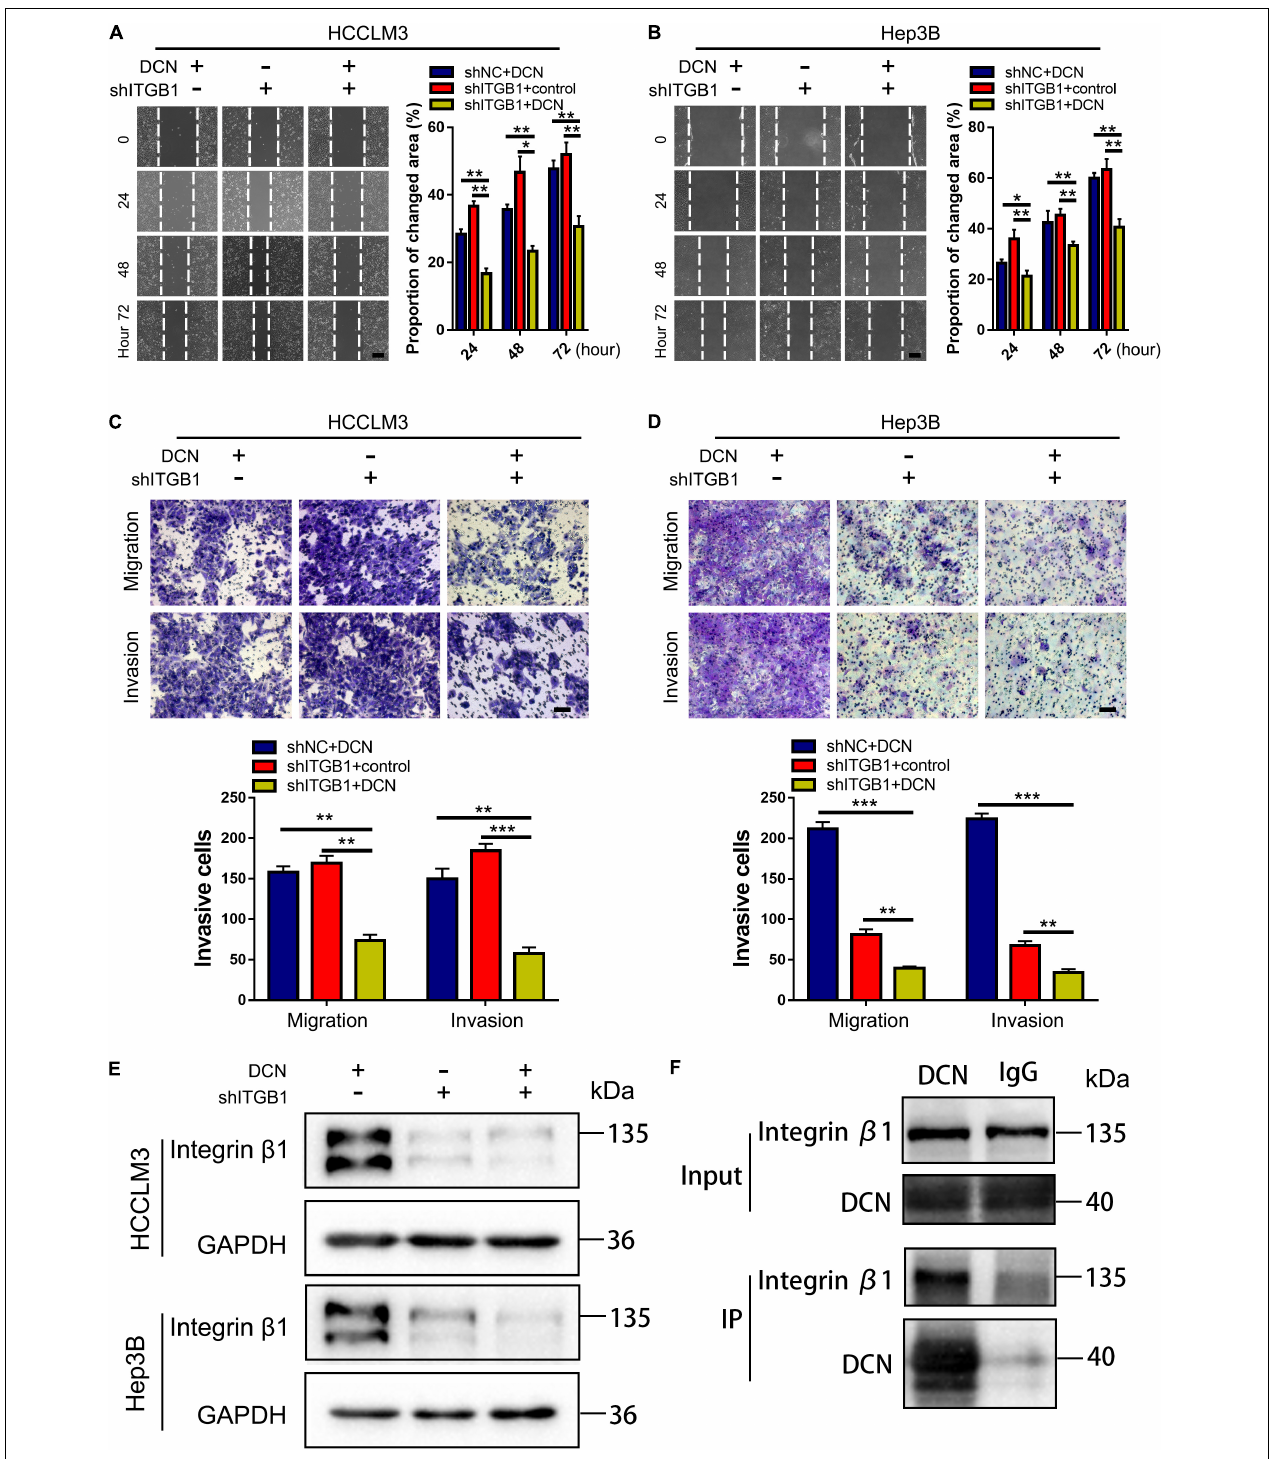
FIGURE 7 | DCN treatment combined with integrin β 1 downregulation synergistically inhibits migration and invasion of HCC cell lines. (A,B) Wound-healing assays using integrin β 1 knocked-down or negative control HCCLM3 (A) , and Hep3B (B) cells treated with DCN (1 µ g/mL) or the negative control. Scale bars, 200 µ m. (C,D) Transwell assays using integrin β 1 knocked-down or negative control HCCLM3 (C) , and Hep3B (D) cells treated with the addition of DCN (1 µ g/mL) or the negative control. (E) Western blot analysis of integrin β 1 expression using integrin β 1 knocked-down or negative control HCCLM3 and Hep3B cells treated with DCN (1 µ g/mL) or the negative control. (F) Co-IP assay of DCN with integrin β 1, as detected by immunoblot analysis. Scale bars, 100 µ m. ITGB1, integrin β 1. Data presented as mean ± SEM. * P < 0.05, ** P < 0.01, and *** P < 0.001, Student’s t -test.